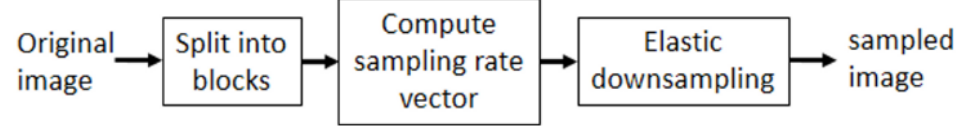
Figure 1. Elastic downsampling